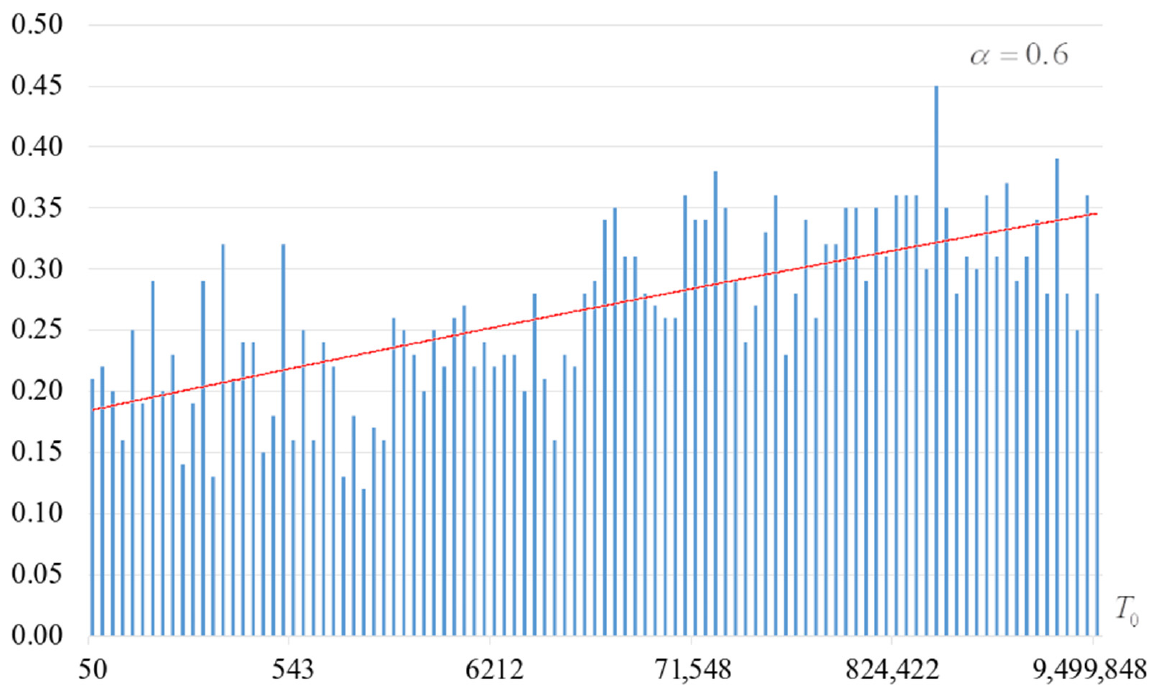
Figure 2. The probability of forming the target S-box at α = 0.6.